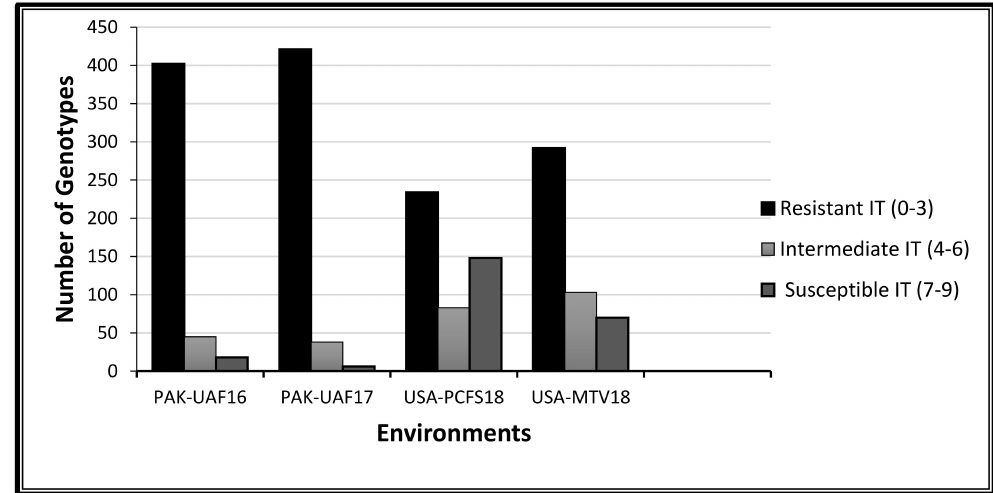
Figure 3. Infection distribution of 465 spring wheat genotypes at the adult plant stage and the stripe rust infection type (IT) score across three environments. Scoring for the adult plant response performed in three di ff erent environments (two years in Pakistan considered as one location and two locations in the